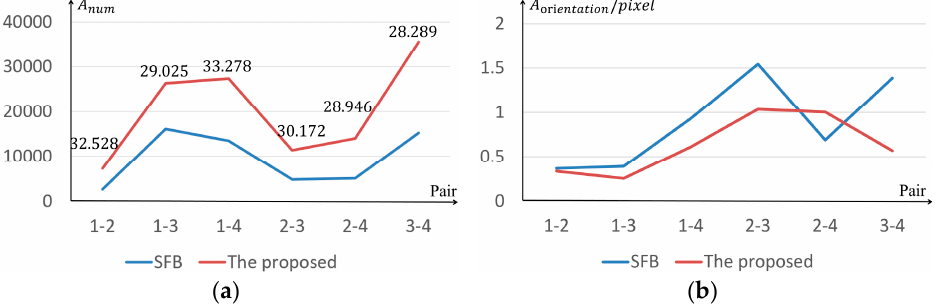
Figure 11. Comparisons with Buenos Aires dataset. ( a ) Comparisons in A num . ( b ) Comparisons in A orientation